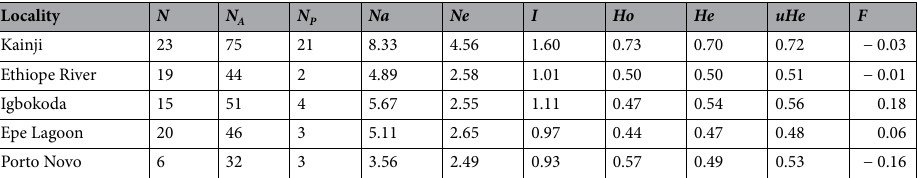
(Table 1): average number of alleles ( Na ) = 8.33; average number of effective alleles ( Ne ) = 4.56; Shannon’s infor- mation index ( I ) = 1.6; observed heterozygosity ( Ho ) = 0.73; expected heterozygosity ( He ) = 0.70; and unbiased expected heterozygosity ( uHe ) = 0.72. The highest number of private alleles was also observed at Kainji Lake: 21 out of 75 alleles in this locality. This sample had a low inbreeding coefficient ( F IS = –0.03). Genetic diversity in the samples from the three southern Nigerian populations were substantially lower: Na ranged between 4.89 (Ethiope River) and 5.67 (Igbokoda); Ne between 2.55 (Igbokoda) and 2.65 (Epe Lagoon); I between 0.97 (Epe Lagoon) and 1.11 (Igbokoda); Ho between 0.44 (Epe Lagoon) and 0.50 (Ethiope River); He between 0.47 (Epe Lagoon) and 0.54 (Igbokoda); uHe between 0.48 (Epe Lagoon) and 0.56 (Igbokoda). In these localities, F IS